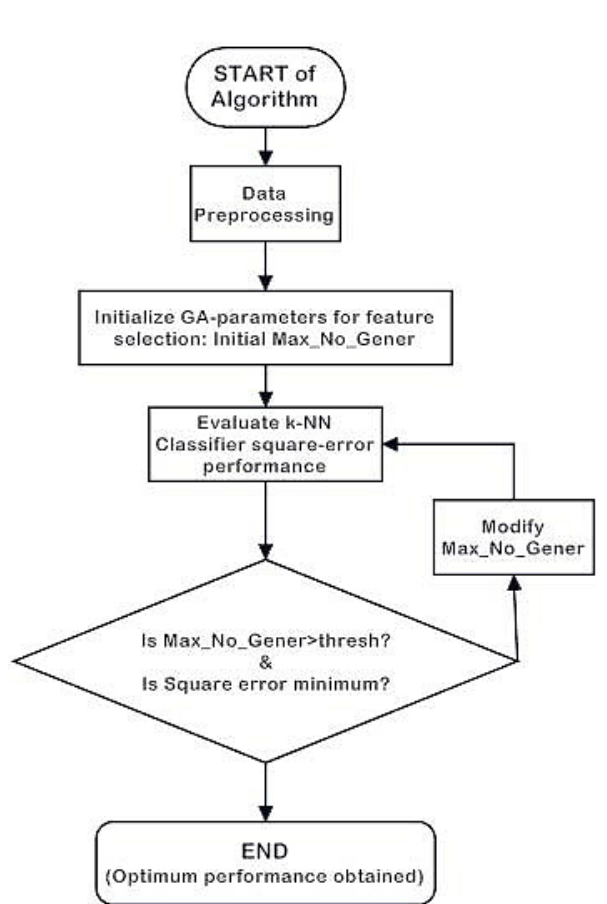
Fig. 6. Flowchart showing the sequences of feature-selection and